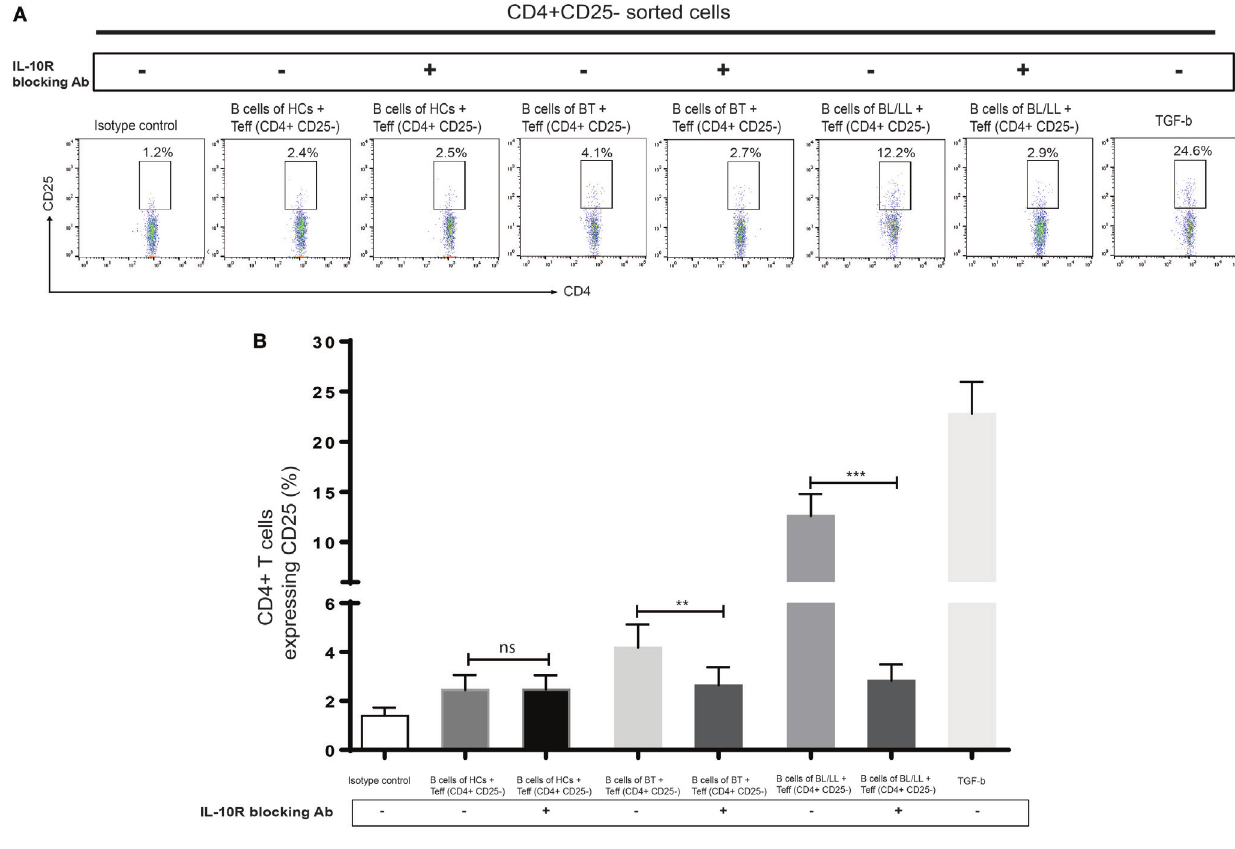
FigUre 5 | Effect of interleukin-10 (IL-10) blocking signaling of regulatory B cells (Bregs) on Teff. (a,B) Representative flow cytometric analysis and graph plot ofTregs (CD4 + CD25 + ). Bregs isolated from HCs, BT, and BL/LL ( n = 6) blocked with antibody against IL-10R and cocultured with Teff and expression of CD25 + on CD4 + was analyzed by flowcytometry after 48 h of culture. Isotype controls and TGF- β (20 ng/ml) were taken as negative and positive controls in both experiments. Mean ± SD values are shown in each set while p value < 0.05 was considered significant. 50,000 cells were acquired and analyzed by flow cytometry. Data analysis was performed with flowjo software. Statistical analysis was done using Student’s t -test for unpaired samples (* p < 0.05; ** p < 0.005; *** p <